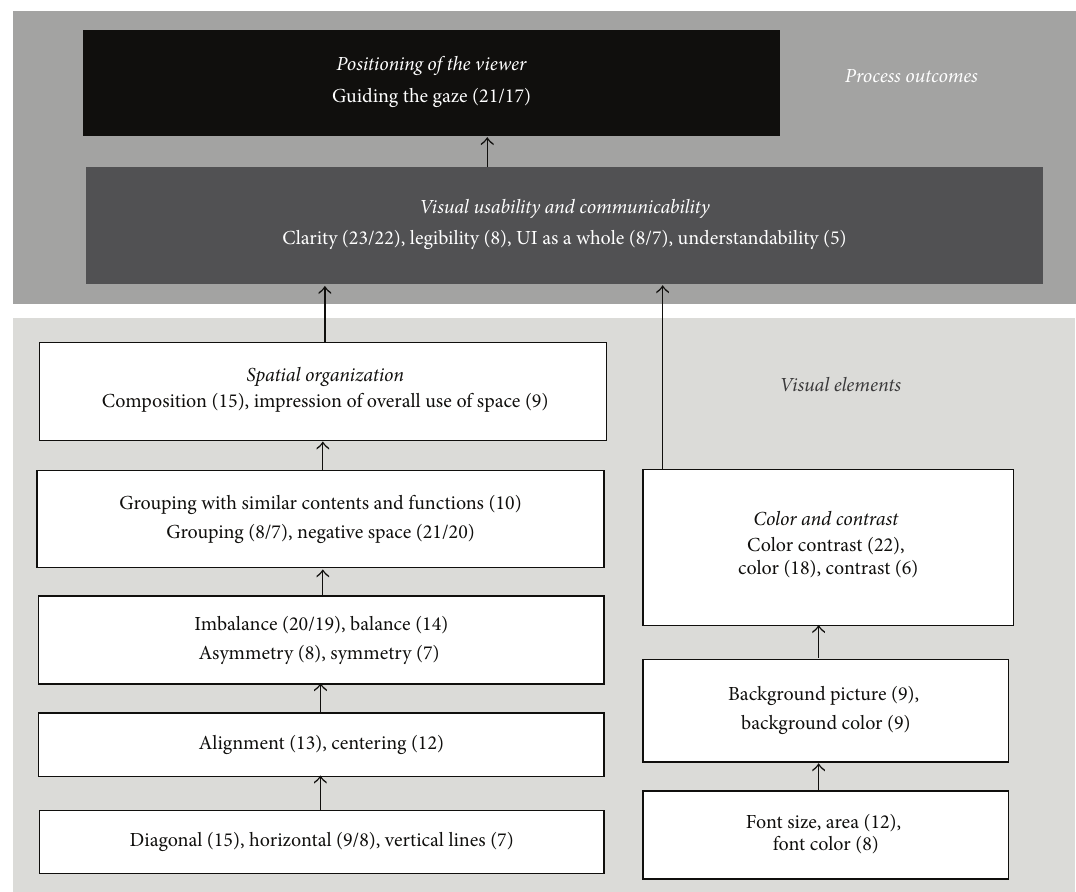
Figure 6: Salient visual elements contributing to positioning of the